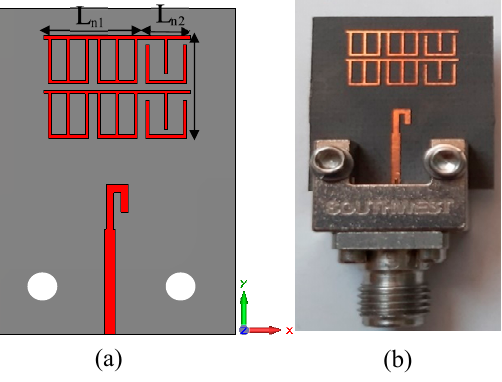
Figure 15. Integration of 2 × 3 MM array with the proposed antenna for negative deflection: ( a ) designed configuration and ( b ) fabricated sample.